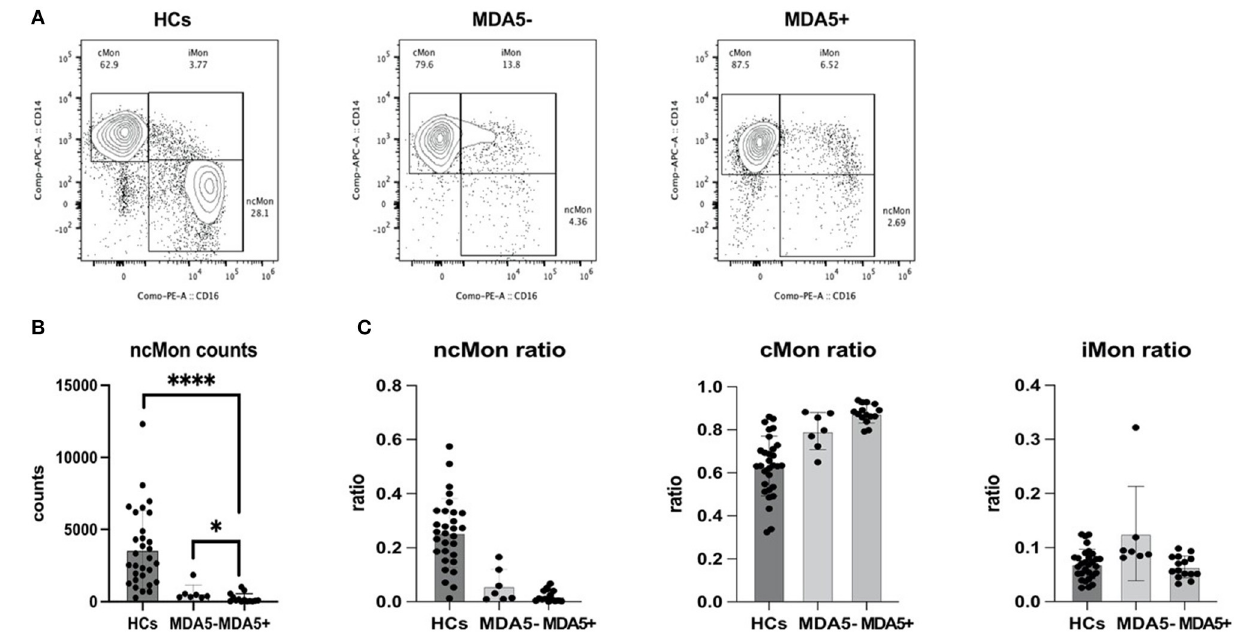
FIGURE 4 | Flow cytometry data demonstrates an excursion of monocyte phenotypes. (A) Representative figure of monocyte phenotypes of healthy controls (HCs), patients with anti-MDA5- (MDA5–) and patients with anti-MDA5 + (MDA5 + ); (B) ncMon of patients with MDA5 + significantly decreased compared with HCs ( p < 0.0001, Mann–Whitney U test) and patients with MDA5- ( p = 0.0250, Mann–Whitney U test); (C) A significant excursion of ratios of ncMon ( p < 0.0001, Kruskal–Wallis test), cMon ( p < 0.0001, Kruskal–Wallis test), and iMon ( p = 0.0102, Kruskal–Wallis test) occurs among the different groups. * p < 0.05; **** p <